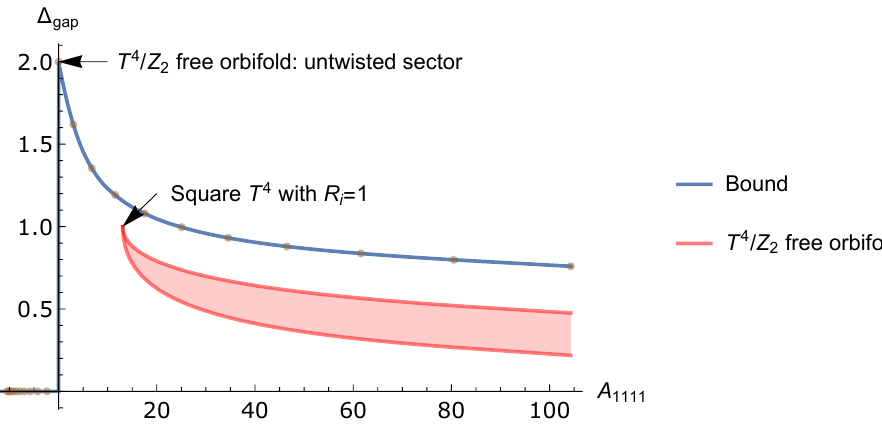
Figure 6 . The solid line shows the upper bound b (cid:1) gap on the gap versus the integrated four-point function A 1111 , at 20 derivative order, which we observe to already stabilize with increment of the derivative order in the range of A 1111 shown here; the dots are the actual data points. The minimal A 1111 and maximal gap are simultaneously saturated by an untwisted sector correlator at the free orbifold point. The shaded region represents the gap in the OPE of twist (cid:12)elds at a (cid:12)xed point of T 4 = Z 2 with a rectangular T 4 , where the minimal A 1111 and maximal gap are achieved by a square T 4 at radii R i = 1 (1 = p 2 times the self-dual